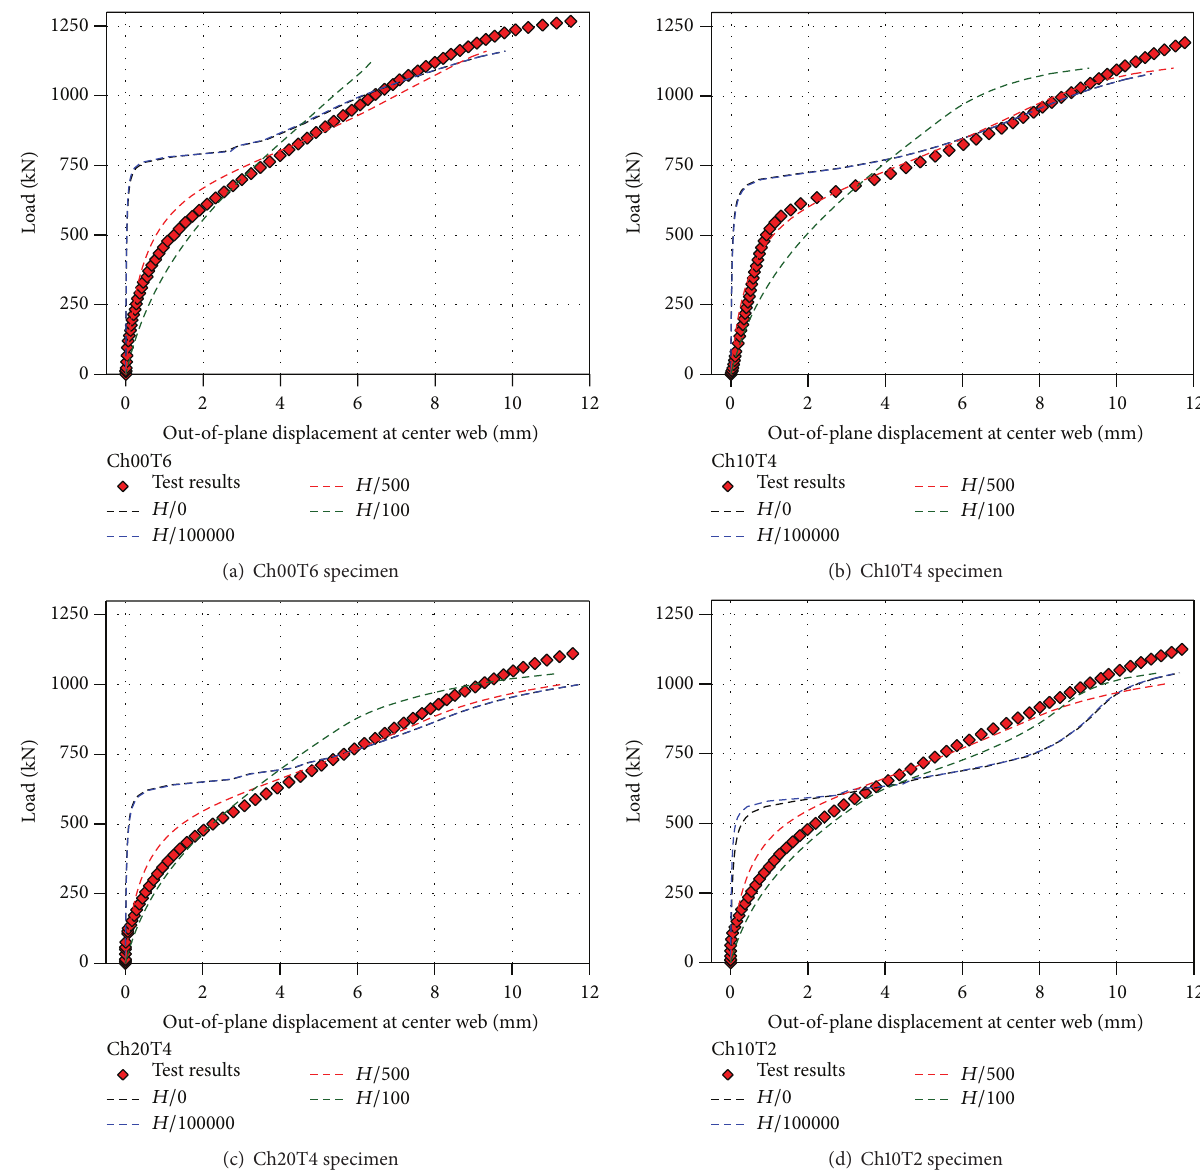
Figure 3: Out-of-plane displacement comparisons at center web of shear buckling test